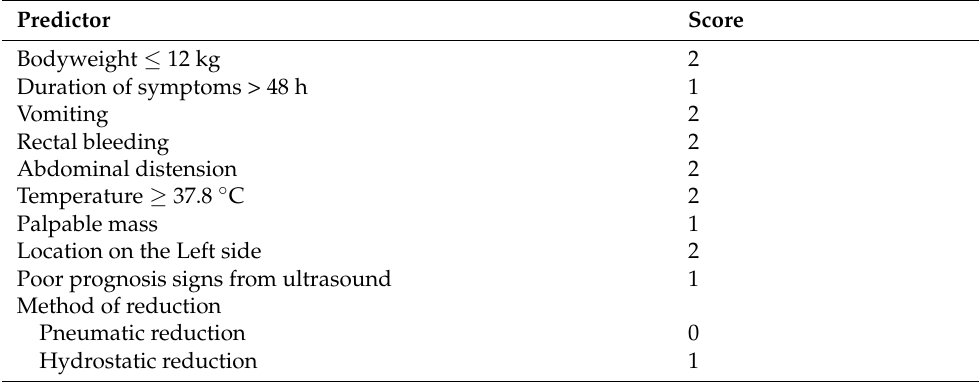
Table 1. Ten predictors of CMUI with score